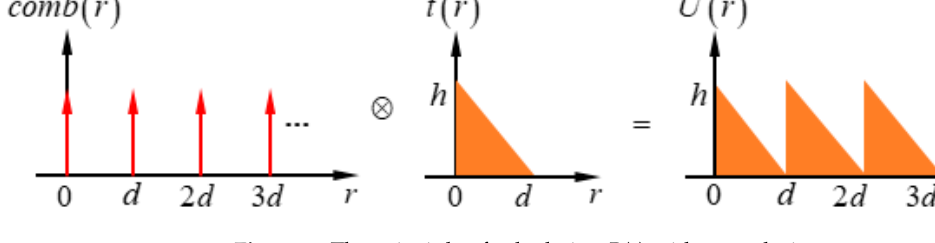
Figure 3. The principle of calculating R ( r ) with convolution.